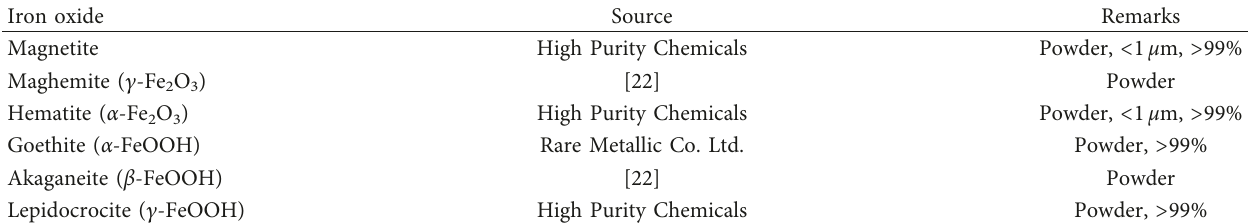
Table 2: Summaries on the commercial companies and synthetic methods of iron oxides used for the standard Raman spectra.